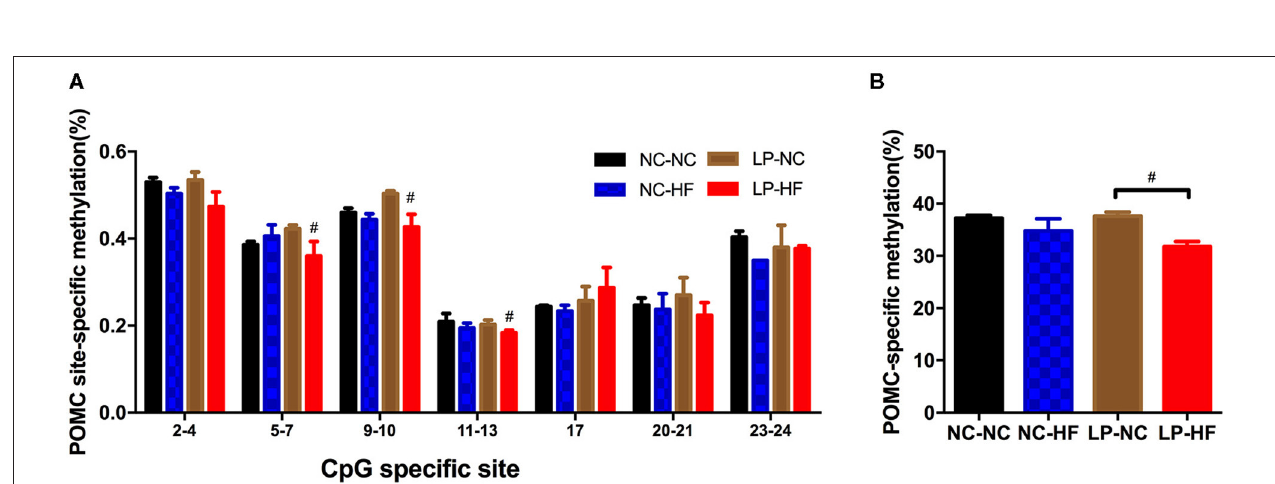
FIGURE 5 | Effects of maternal protein restriction and post-weaning high-fat feeding on POMC methylation in offspring. (A) Methylation level (%) of specific CpG site in POMC gene promoter; (B) POMC-specific methylation (%). POMC site-specific methylation (%). Data were represented as mean ± SEM ( n = 6–8/group). # P < 0.05 LP–HF vs. LP–NC group. Diet abbreviations: NC, normal chow; LP, low protein; HF, high fat. Dam and pup diets denoted before and after the dash line, respectively.